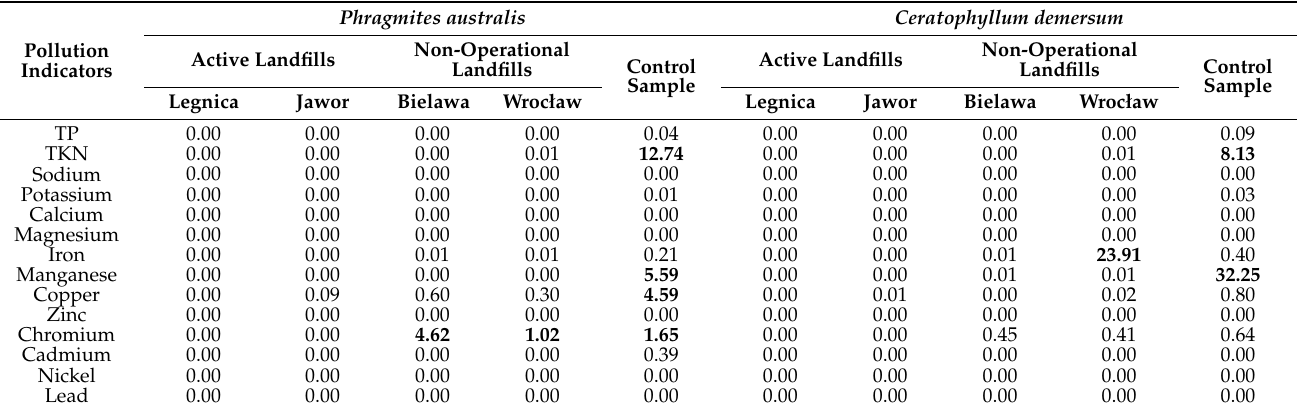
Table 2. Bioconcentration factor (BCF) for Phragmites australis and Ceratophyllum demersum (for P. australis , the average for roots and stems was